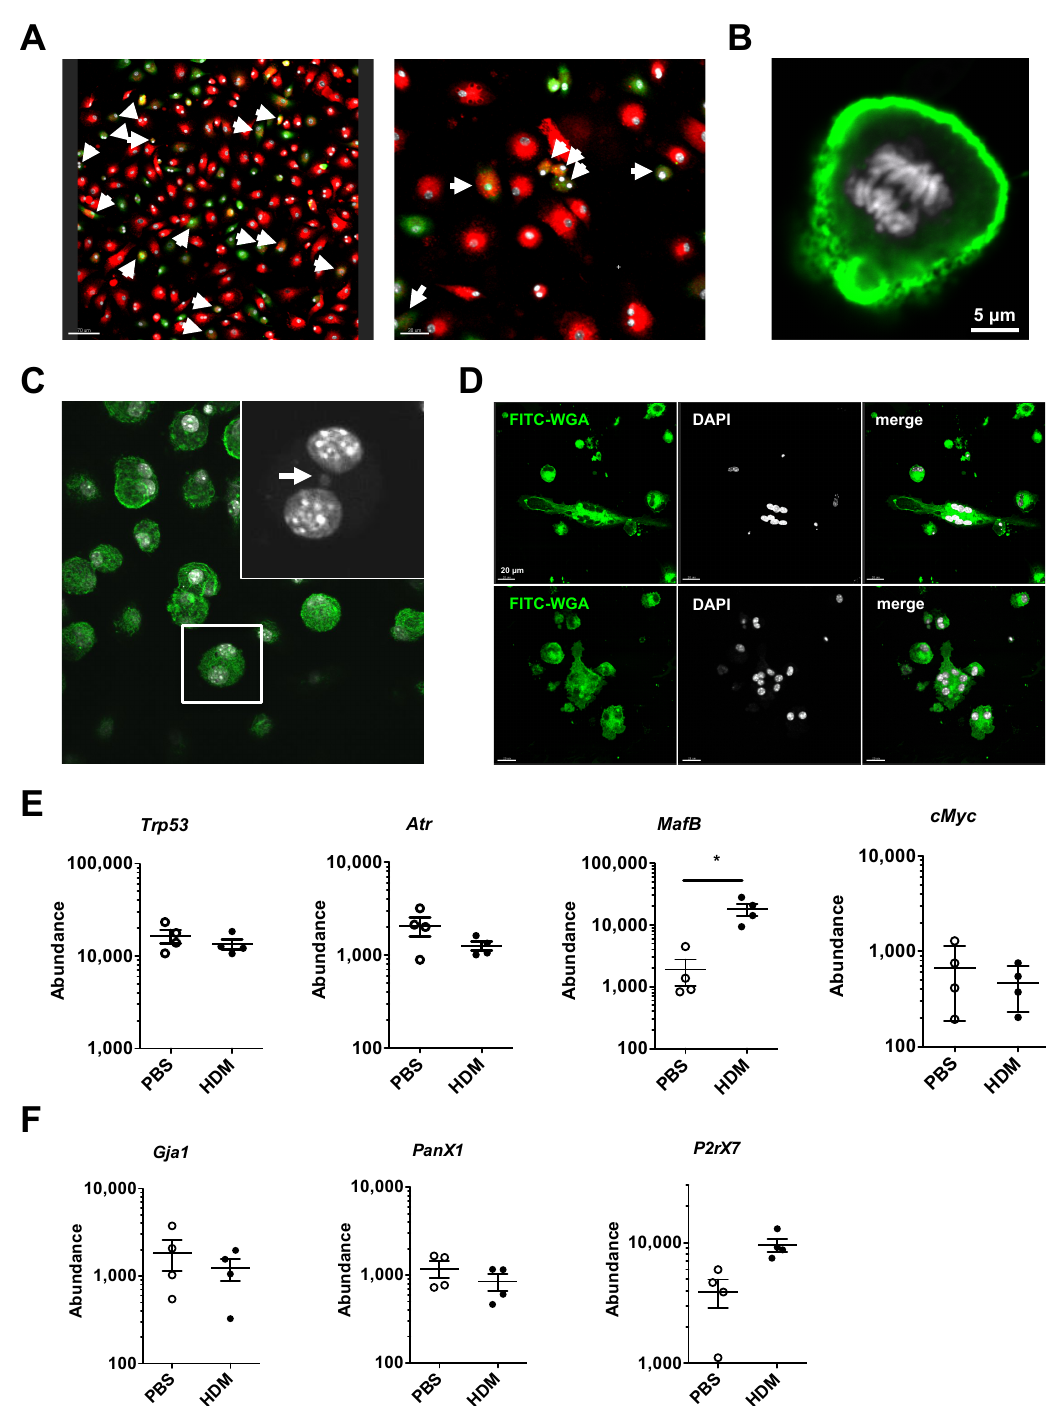
Figure 4. tAM polynucleation arise from division defect rather than cell fusion. ( A ) Assessment of fused macrophages by confocal microscopy (original magnification × 20 / × 40). Cell fusion was assayed by cultivating for 5 days with sorted SiglecF + CD11c + tAMs stained with PKH26 (red) or CFSE (green) and counterstained with DAPI (white). Bars represent 70 / 30 µ m. Arrows show cells positive for both red and green staining. ( B ) SiglecF + CD11c + tAMs cultivated with GM-CSF show signs of proliferation. Cells were stained with FITC-WGA (green), counterstained with DAPI (white) and examined by fluorescence microscopy (original magnification × 60). ( C ) Evidences of division defect of tAMs by confocal microscopy (original magnification × 40). tAM cultivated with GM-CSF shows the presence